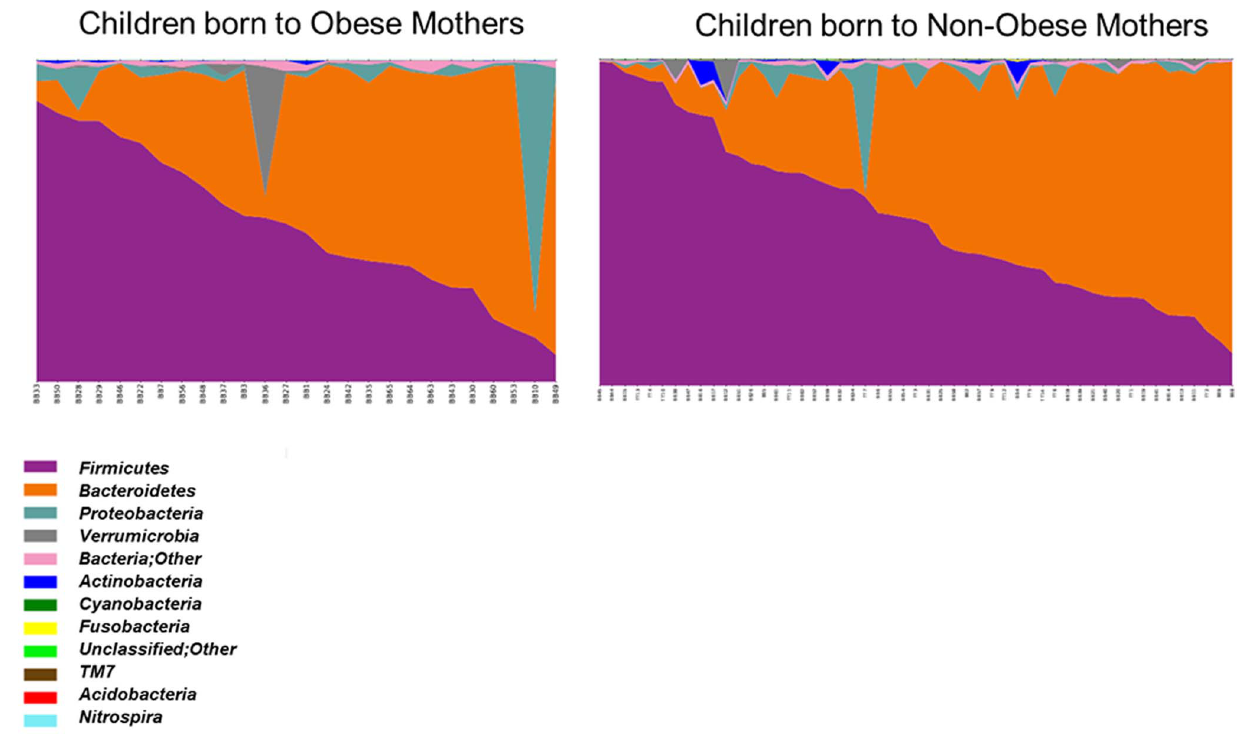
Figure 5. Across individuals, there was considerable variance in the Firmicutes:Bacteroidetes ratio, as shown. However, there were no differences between the children born to obese versus non-obese mothers in abundances of the major phyla, Firmicutes ( p =0.667) and Bacteroidetes ( p =0.914).